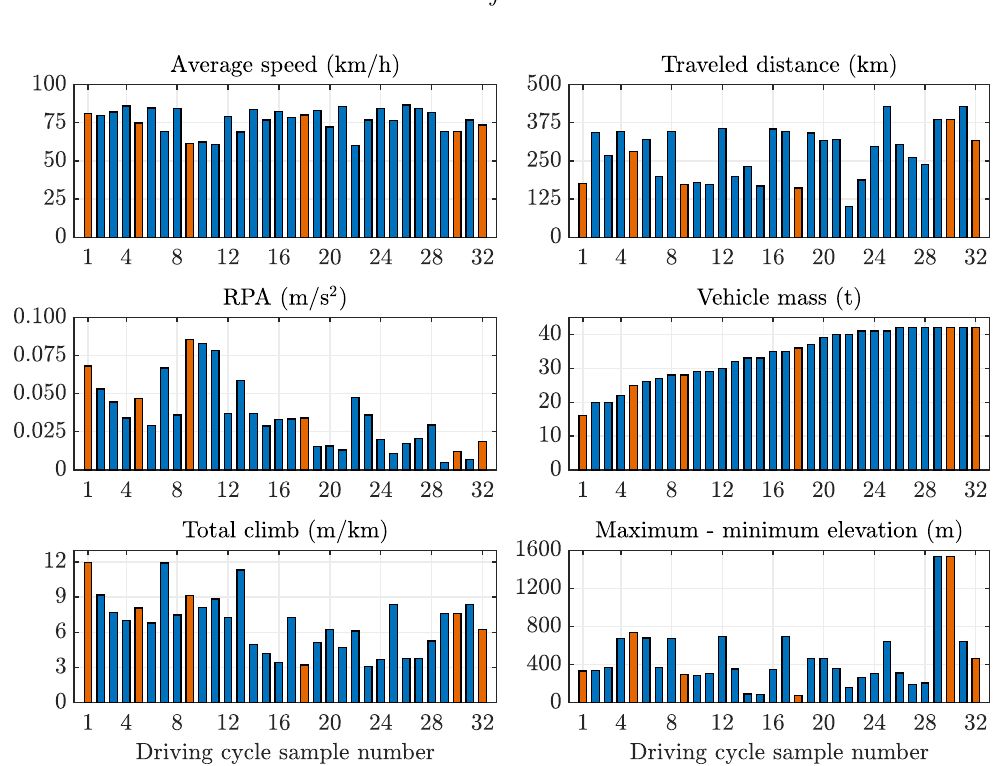
Figure 3. Key properties of the real-world driving cycles under investigation in this work. The cycles are sorted by vehicle mass, which ranges between 16 and 42 tons. In total, the traveled distance is 8935 km and the driving time 116